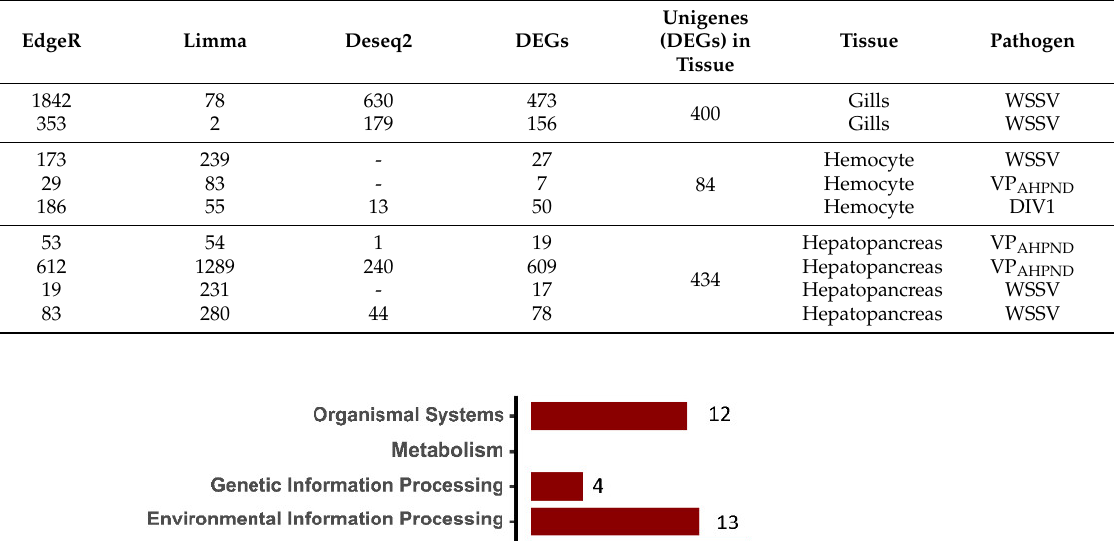
Table 3. The number of differentially expressed genes (DEGs) found in gills, hemocytes, and hep- atopancreas of P. vannamei under WSSV, VP AHPND , or DIV1 infection compared to control group.